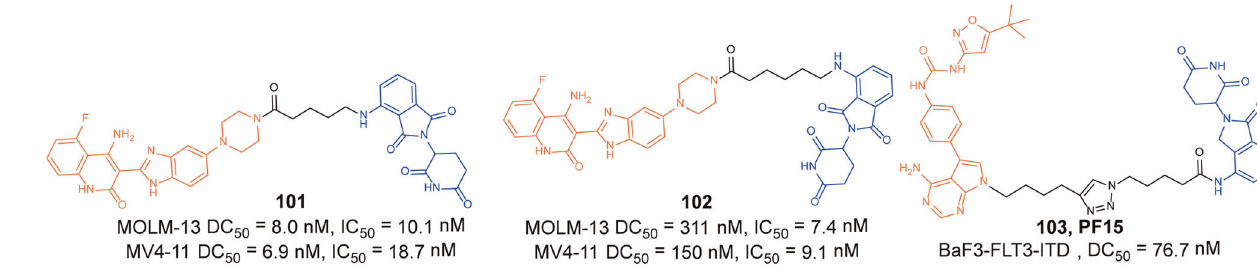
Fig. 24 The representative PROTACs targeting